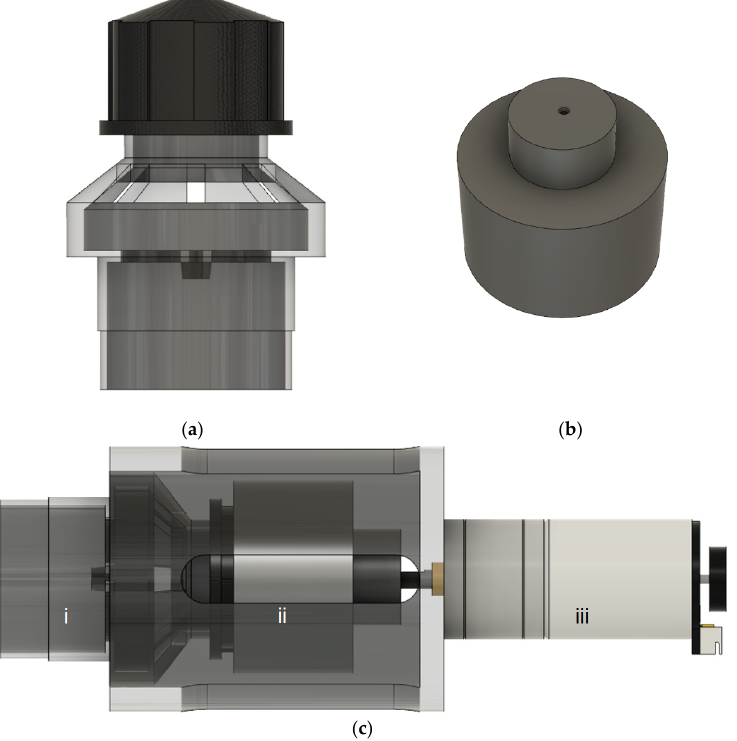
Figure 4. Motorized PEEP valve: ( a ) commercial Ambu-bag PEEP valve; ( b ) motor–valve coupling part; and ( c ) motorized PEEP valve showing (i) PEEP valve, (ii) motor–valve coupling, and (iii) mo- tor.